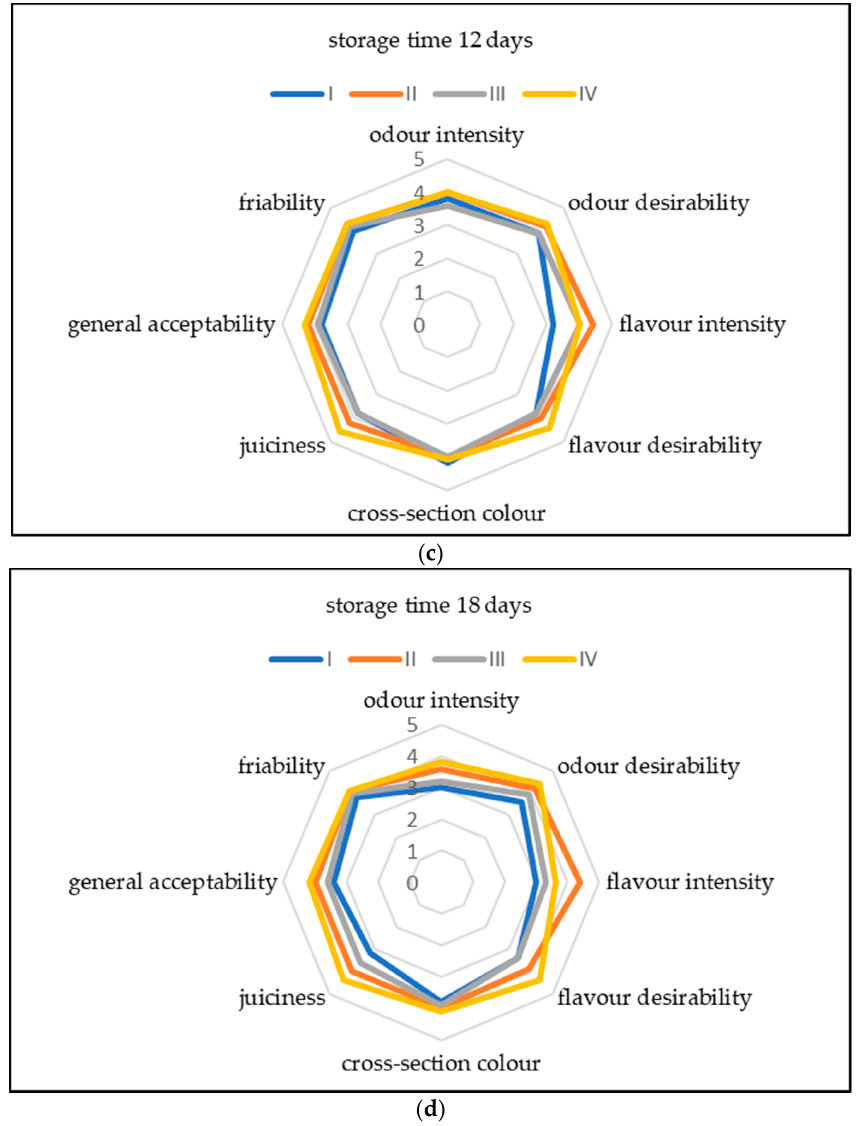
Figure 2. Effect of turmeric addition and storage time on sensory evaluation in duck burgers, storage time: ( a ) 1 day; ( b ) 6 days; ( c ) 12 days; ( d ) 18 days. Explanations: Group I—control, group II—with turmeric powder, group III—with turmeric extract, group IV—with turmeric paste.